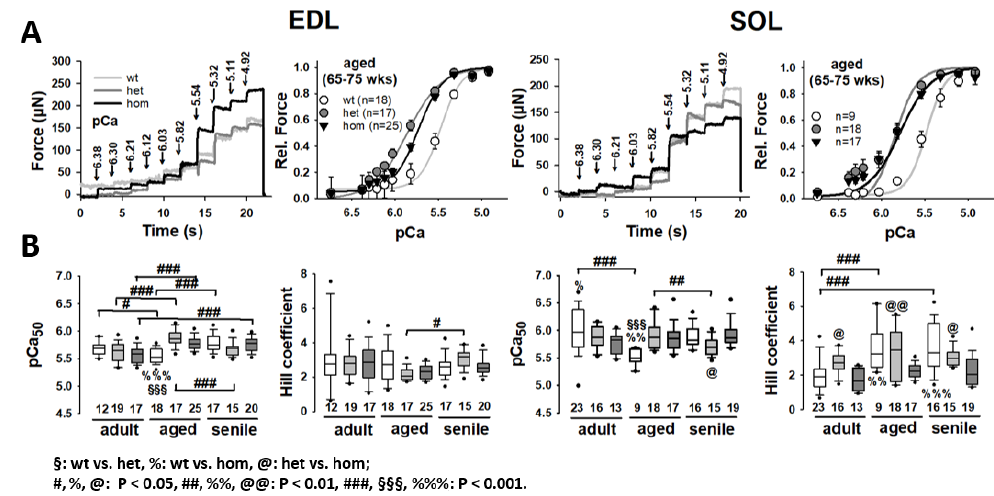
Figure 2. Ca 2 + sensitivity of the contractile apparatus in single EDL and SOL fibers from adult, aged, and senile R349P desmin mice. ( A ) Representative force recordings in an aged single EDL (left) and SOL (right) fiber for each genotype showing increasing force for each pCa step change. The mean pCa–force curves along with the mean reconstructed Hill fit to the data are shown to the right. The curves display a marked left-shift in the R349P desmin knock-in background. Group analysis of pCa 50 values and Hill coefficients in panel ( B ) show a significantly increased Ca 2 + sensitivity in aged R349P desmin knock-in animals over the wt which is caught up in the senile group. Likewise, in the adult age group, Ca 2 + sensitivity is similar between genotypes. In EDL, there is a significant trend towards increasing Ca 2 + sensitivity in the R349P desmin knock-in background with age, while in SOL, significant age-related changes were only observed in the wt. Overall, differences between wt and hom preparations became more distinct with age. Significance tested with two-way ANOVA followed by post hoc analysis (Bonferroni). Numbers in box plots: number of single fibers